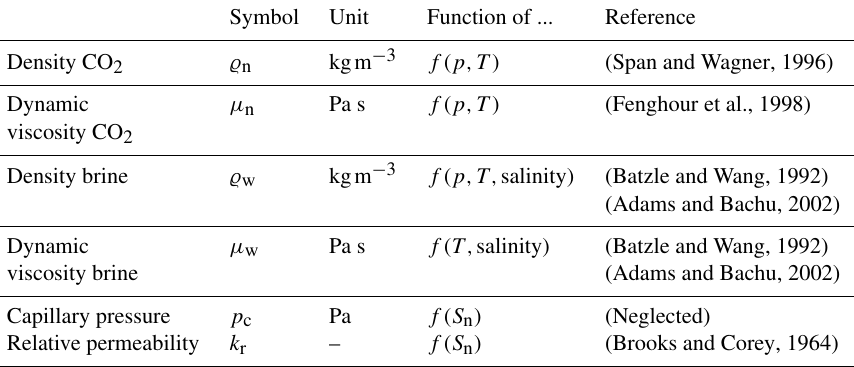
Table A1. List of equations of state used for calculating the fluid properties of CO 2 and brine as well as relationships for capillary pressure and relative permeability. The salinity is defined here as the mass fraction of